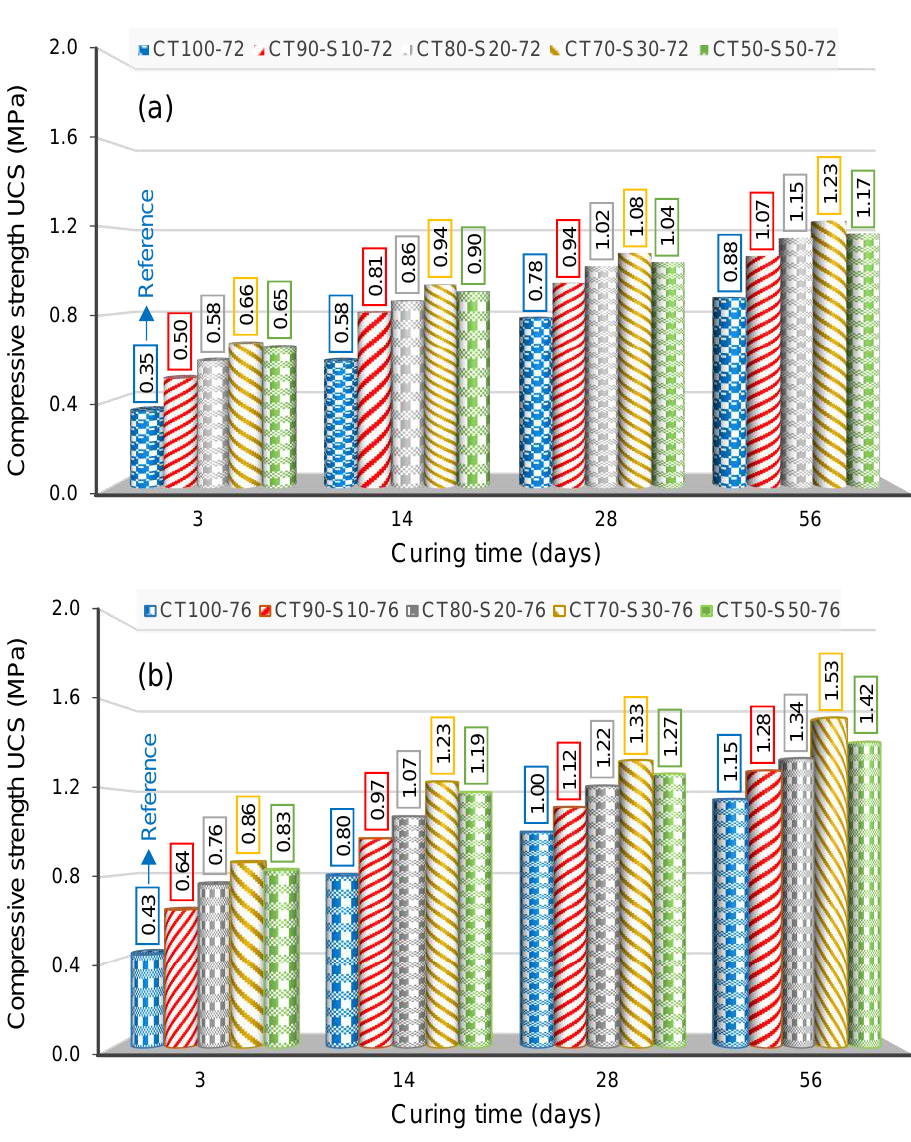
Figure 3. The compressive strengths of CPB with different sand ratios: ( a ) 72 wt.% and ( b ) 76 wt.%. The average strengths of the reference samples (CT100-72 and CT100-76) for different curing times were found to be 0.35, 0.58, 0.78, and 0.88 MPa, as well as 0.43, 0.80, 1.00, and